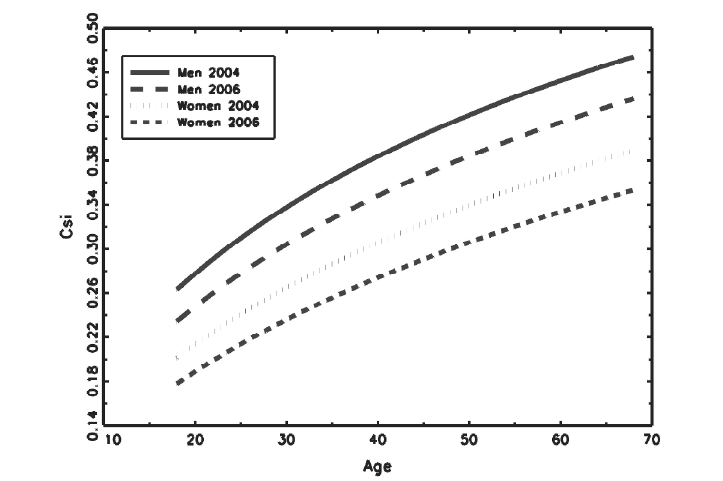
Figure 7 – Feeling parameter, given Gender and Time, for varying